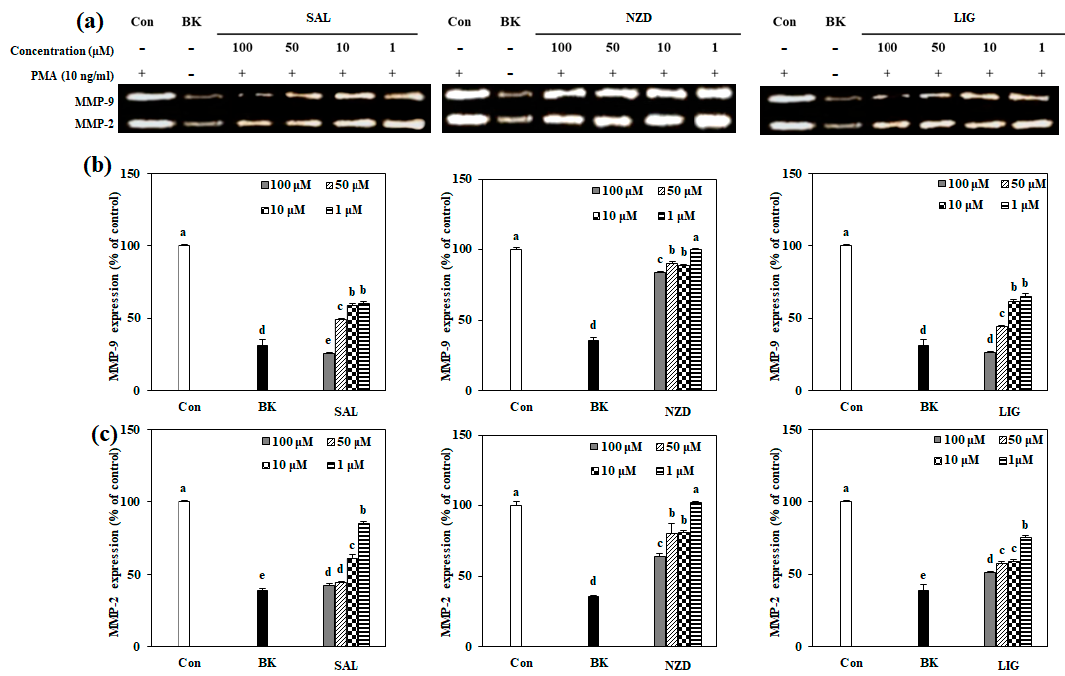
Figure 3. Effects of SAL, NZD and LIG on the levels of MMP-9 and MMP-2, evaluated by gelatin zymography in HT1080 cells (Con: untreated PMA-stimulated cells; BK: untreated unstimulated cells). ( a ) Gelatinolytic activities of MMP-9 and MMP-2 on gelatin containing 10% polyacrylamide gel. White areas in gelatin zymography, which represent digestion by active MMP-9 ( b ) and MMP-2 ( c ), were quantified by densitometry. Control and blank were without treated samples and blank was also without PMA. a–e Means with different letters at the same concentration are significantly different ( p < 0.05), as assessed by Duncan’s multiple range